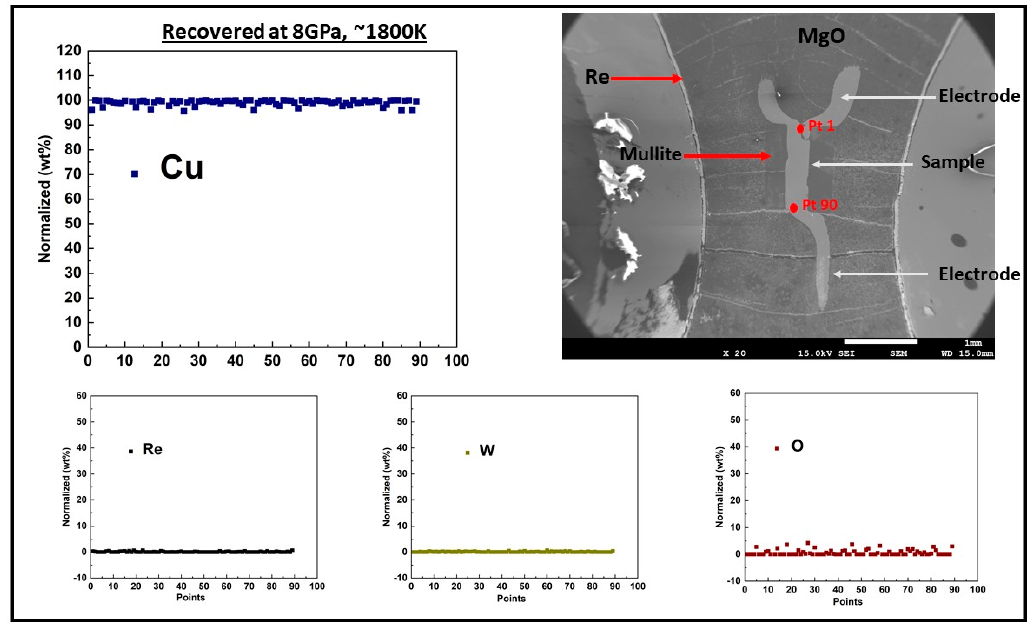
Figure 2. Backscattered electron (BSE) image of ex − situ recovered Cu sample at 8 GPa and ∼ 1800 K along with a plot of line profile of electron microprobe (EPMA) results. The line from point 1 to 90 was divided into units and each unit measured about 10 − 14 µm. The fourth electrode was lost during sectioning to expose the center part of the sample.